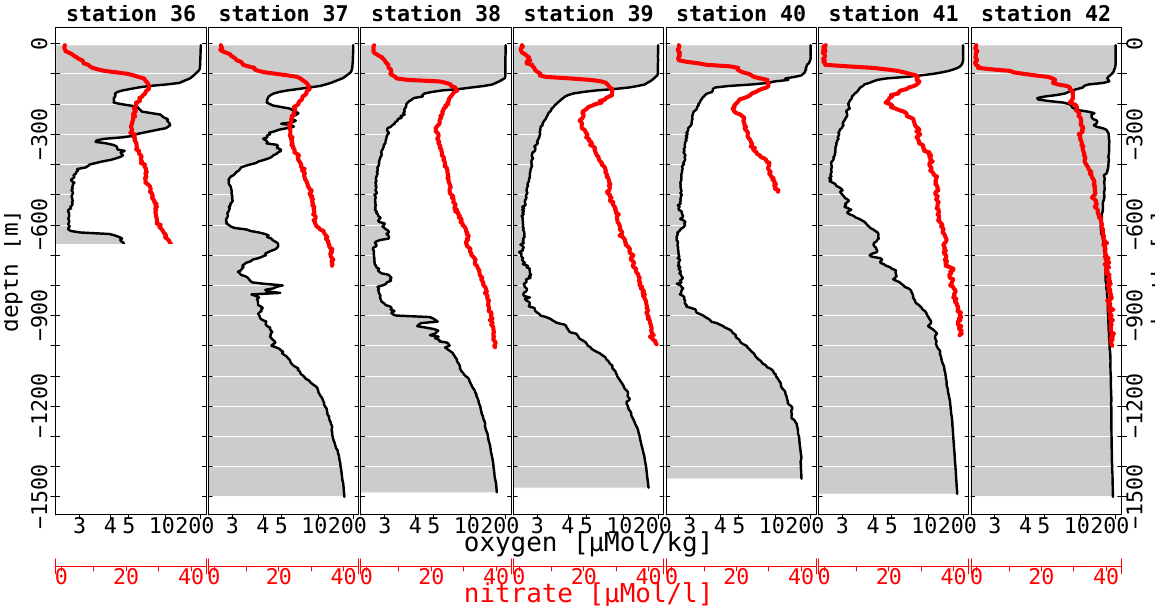
Figure 4. Vertical profiles of nitrate (red) with oxygen concentration background (grey colour).